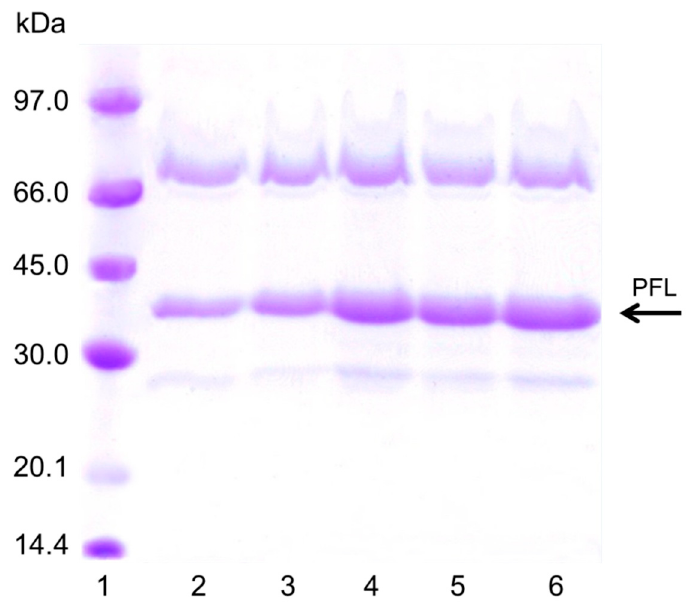
Figure 5. SDS-PAGE of the different immobilized PFL preparations. The experiments were performed as described in Methods (load was 80 mg/g per layer). Lane 1: Low molecular marker; Lane 2: Octyl Agarose-PFL, Lane 3, OA-PFL-PEI, Lane 4: OA-PFL-PEI-PFL, Lane 5: OA-PFL-PEI-PFL-PEI, Lane 6: OA-PFL-PEI-PFL-PEI-PFL.